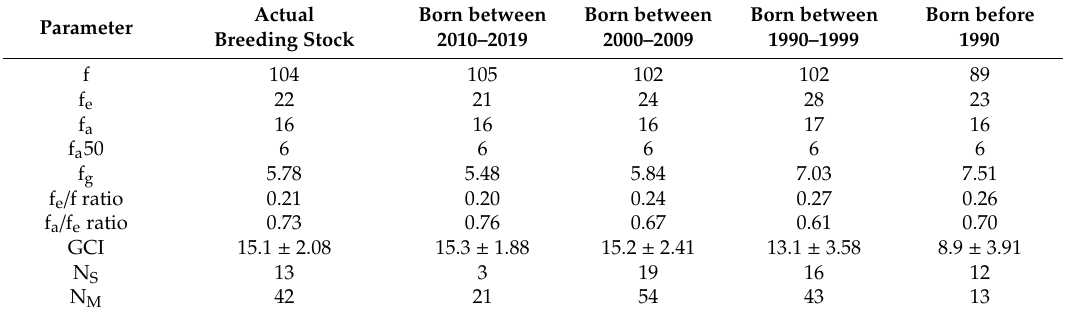
Table 3. Demographic parameters of the Hungarian Hucul horse population by birth